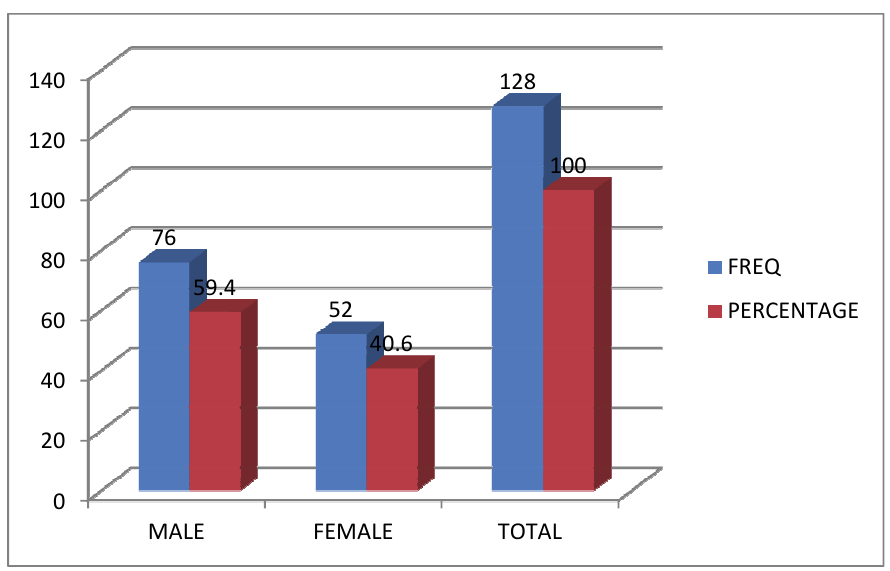
Figure 1: Bar Chart of Sex Distribution of